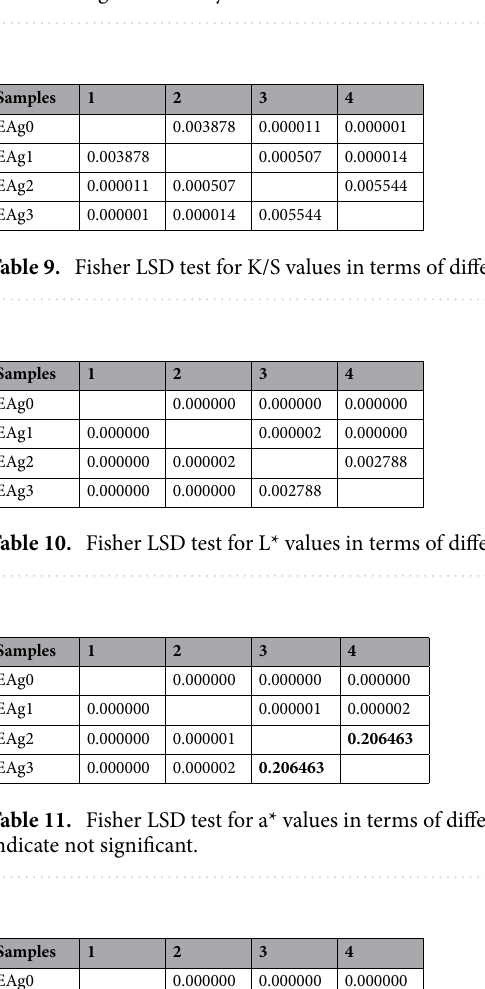
Table 8. Regression analysis for b* values in terms of nanosilver loading.